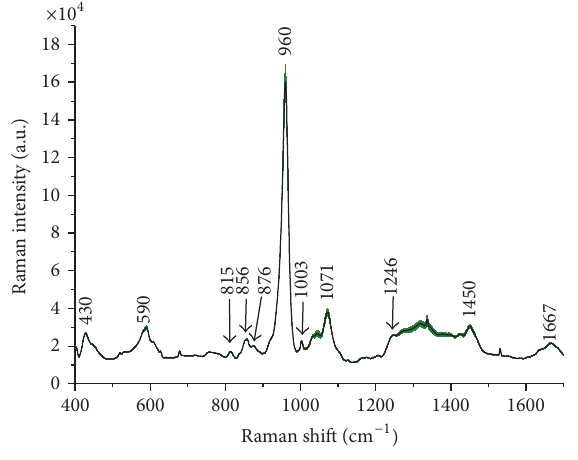
F 1: e mean Raman spectrum of the normal bone tissue sample. e shaded areas represent the standard deviations of the